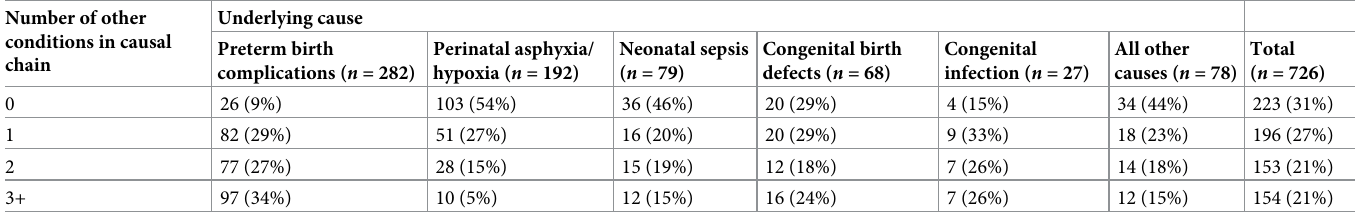
Table 5. Number of conditions in causal chain: Neonates.